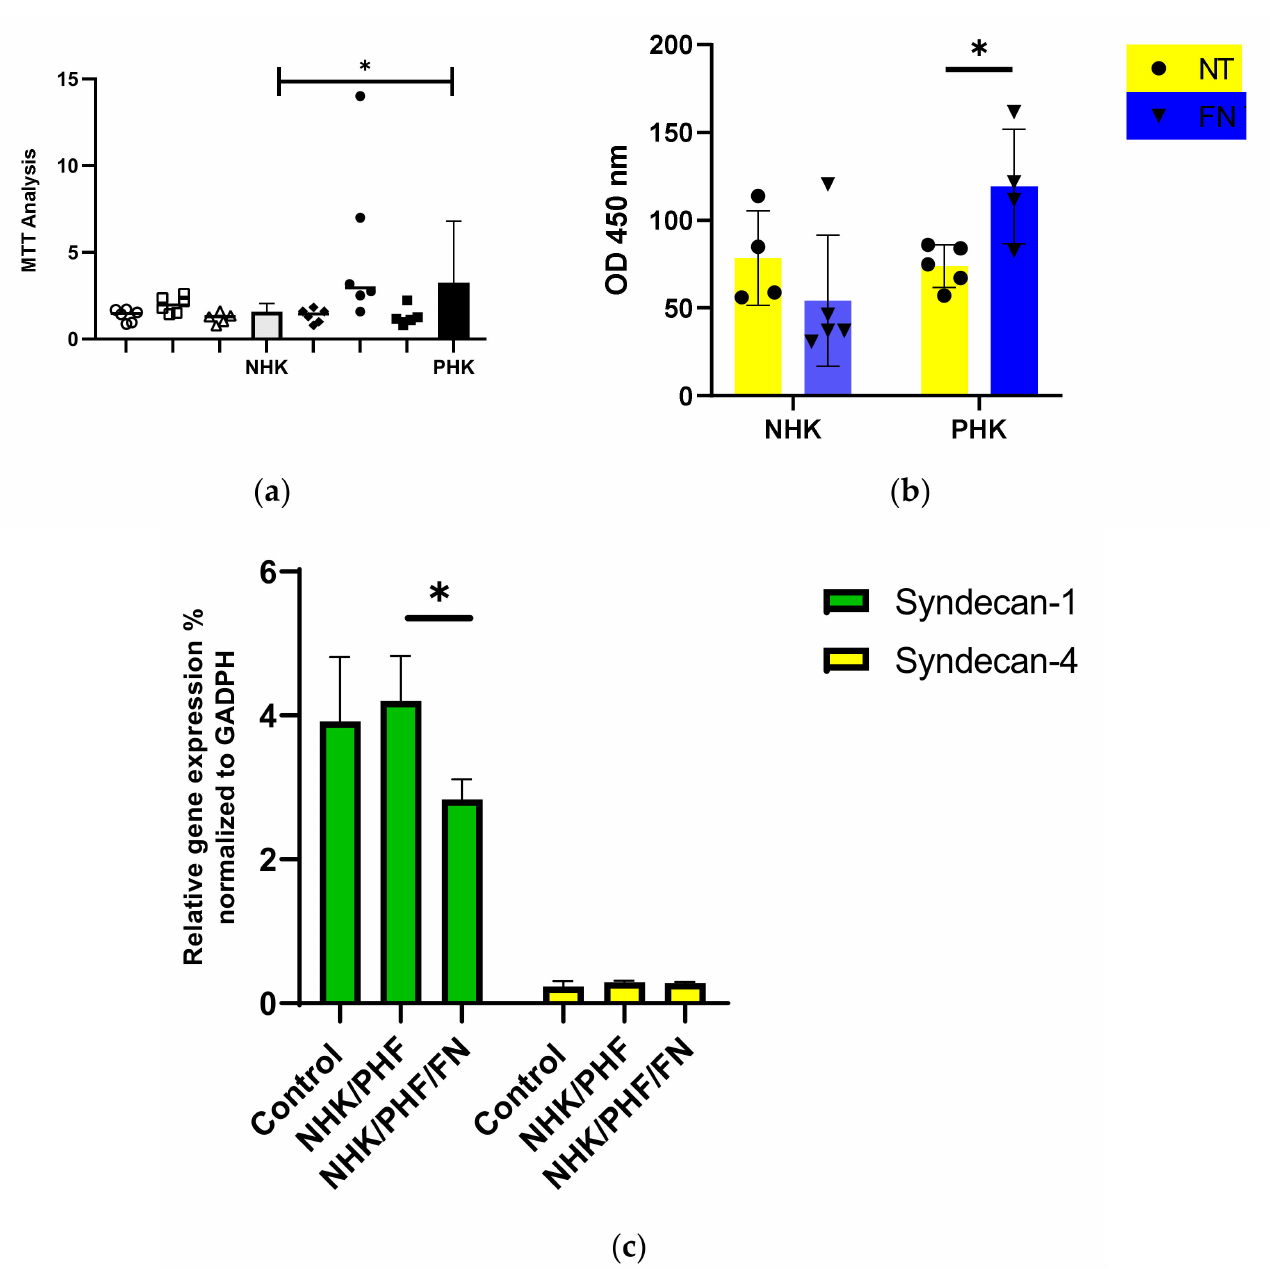
Figure 3. Keratinocytes from the psoriatic lesion respond differently upon attachment to a fibronectin (FN) substrate than healthy ( a ) MTT analysis of growth rate after 24 h attachment to a recombinant FN substrate. Three donors of each group were analyzed. The number of replicates per donor are demonstrated on the graph, mean ± SD, t-student test, * p < 0.05. ( b ) ELISA detection of TNFa in the cell culture medium in response to attachment to FN. One donor of each group was analyzed in such replicates as demonstrated on the graph mean ± SD, t-student test, * p < 0.05. ( c ) QPCR analysis of syndecan-1 and -4 expression in normal keratinocytes after co-culture with psoriatic fibroblasts with or without FN substrate. Experiment performed in triplicates, statistical analysis mean ± SD, multiple t-student tests, * p <